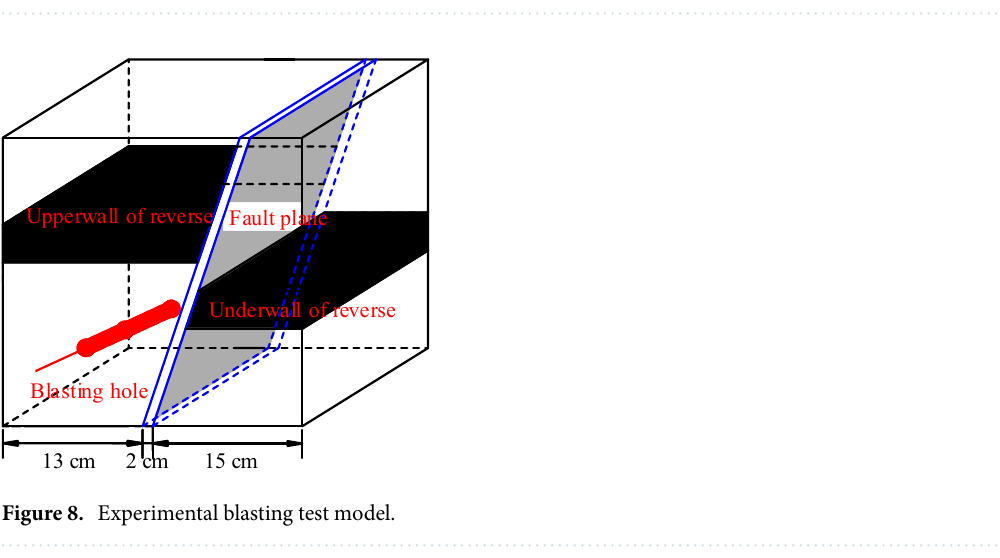
Figure 7. Experimental cartridge production system with ( a ) detonator, and ( b ) blasting cartridge.